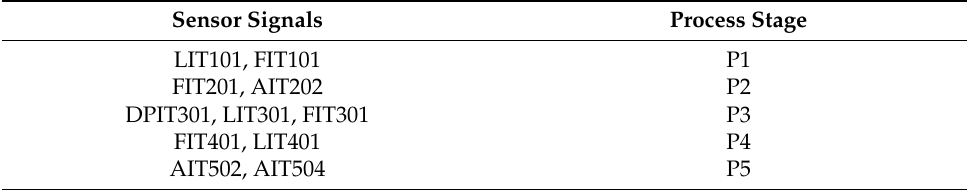
Table 2. Signals from sensors that contributed to the final attack